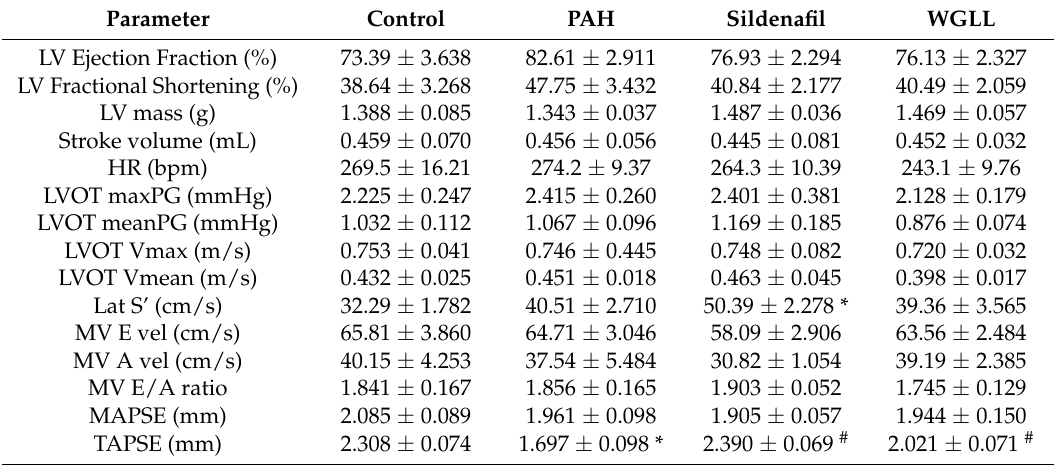
Table 2. Echocardiographic data of the four rat test groups in the study. Right ventricle function was estimated using tricuspid annular plane systolic excursion (TAPSE). Significant decreases were found in TAPSE values of PAH (pulmonary arterial hypertension) group animals compared to the Controls. Values for animals receiving sildenafil injection and Wild garlic ( Allium ursinum ) liophylisate-enriched chow (WGLL) were elevated in comparison to the PAH